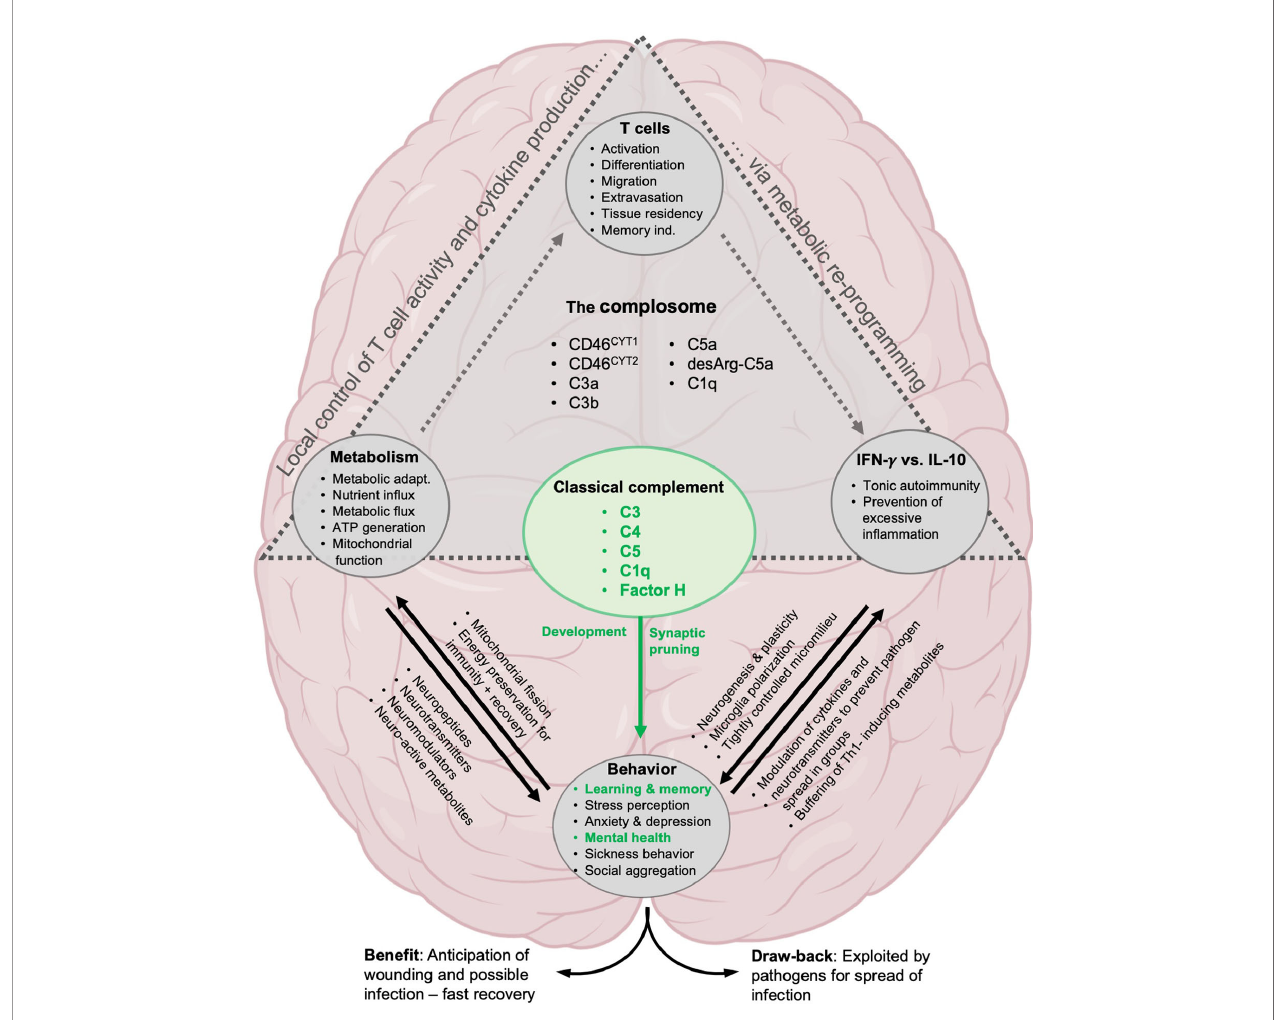
FIGURE 4 | Proposed involvement of the complosome in behavioral control. The direct effect on brain development by classical complement system is well established: C1q and C3 mediate synaptic pruning, neurogenesis, cognitive functions and are important for mental health (green text). Likewise, the role of complement and the complosome in particular in the control of local T cell responses via metabolic reprogramming has been well described (gray triangle, see text for details). We propose that the complosome is heavily involved in most of the known effects of T cells, metabolism and cytokines (IFN- g and IL-10) on neural functions underlying cognition and